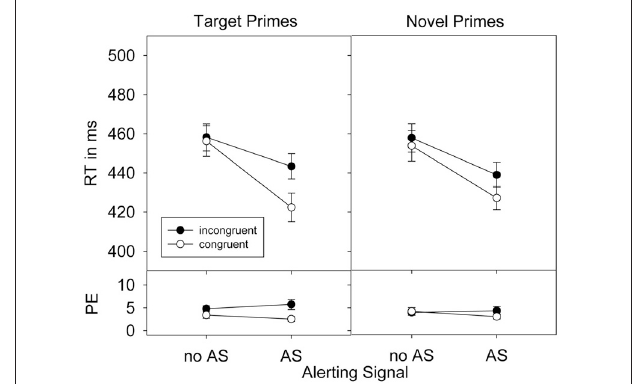
FIGURE 3 | Response times (RTs), standard errors of the means, and percent error (PE) in Experiment 2 as a function of prime-target congruence, prime type, and alerting signal